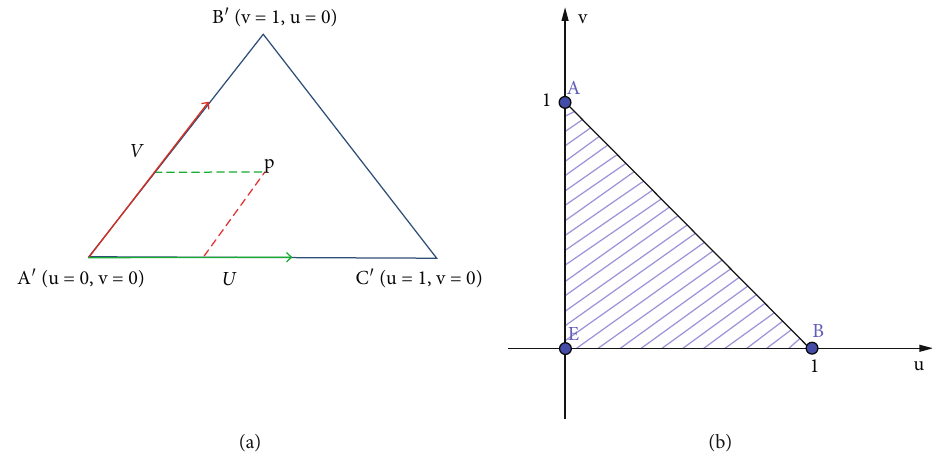
Figure 8: Schematic diagram of geometric relationship of landing point judged by the gravity center method.